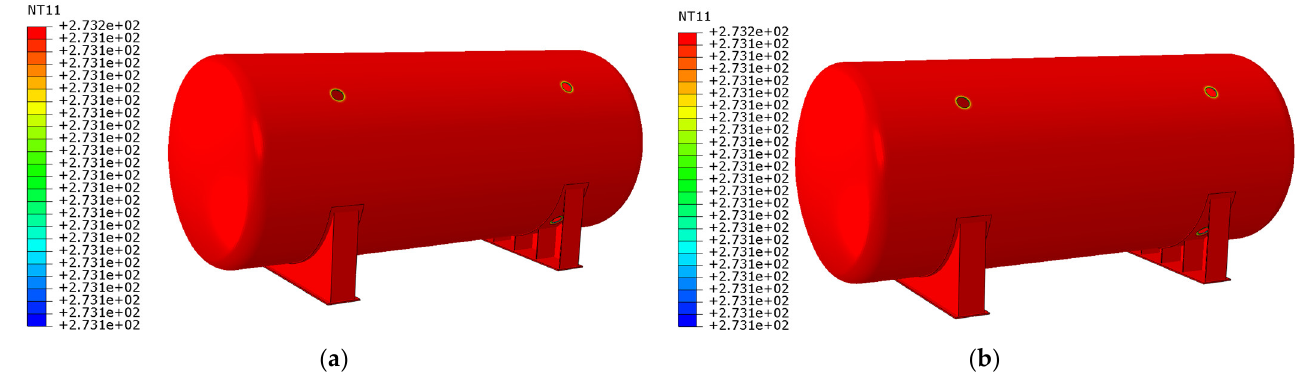
Figure 8. Temperature distribution of outer tank: ( a ) SUS304; ( b ) AL-5083-O.